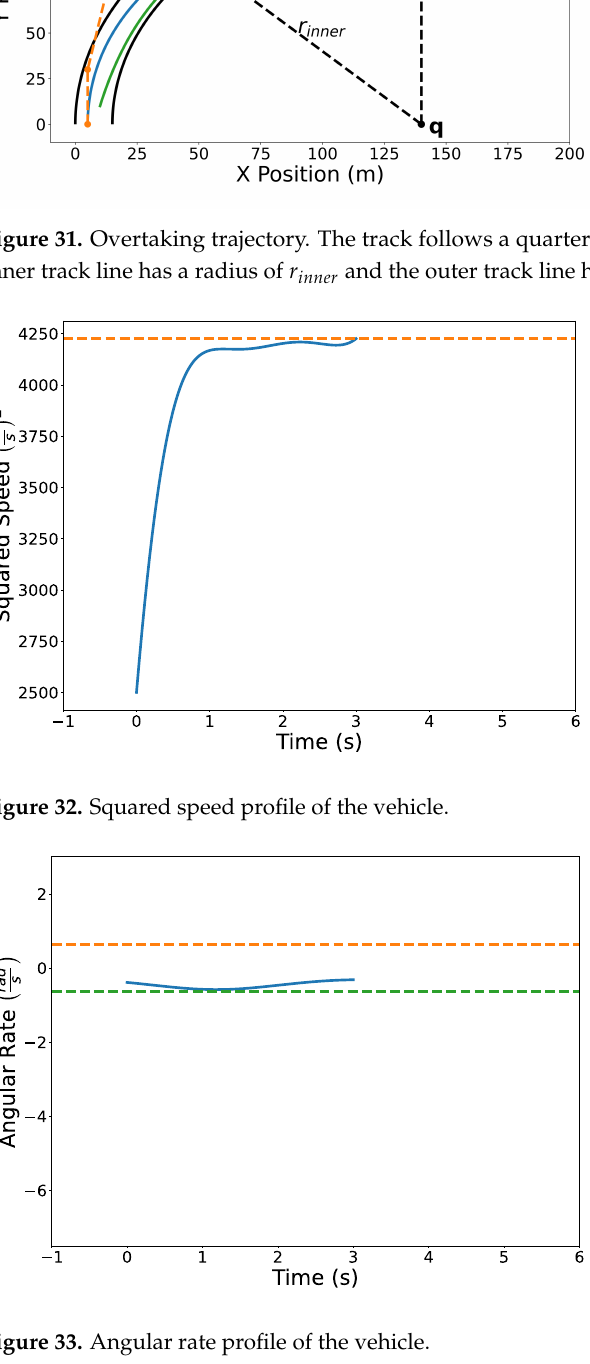
Figure 33. Angular rate profile of the